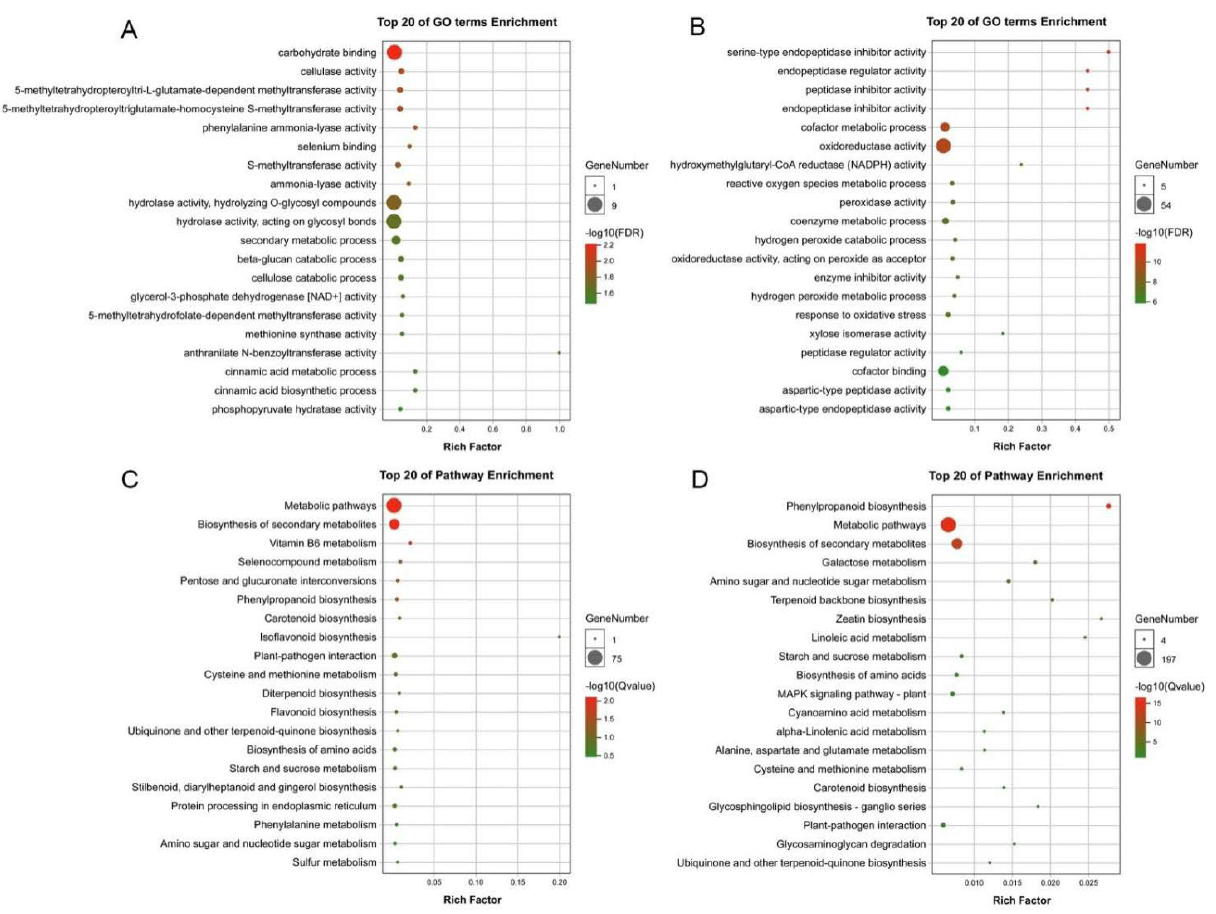
Gene enriched on different GO terms and KEGG pathway. ( A ) GO term enrichment anal- ysis of the early aluminum-responsive genes. ( B ) GO term enrichment analysis of the late aluminum−responsive genes. ( C ) KEGG pathway enrichment analysis of the early aluminum−responsive genes. ( D ) KEGG pathway enrichment analysis of the late aluminum−responsive genes.